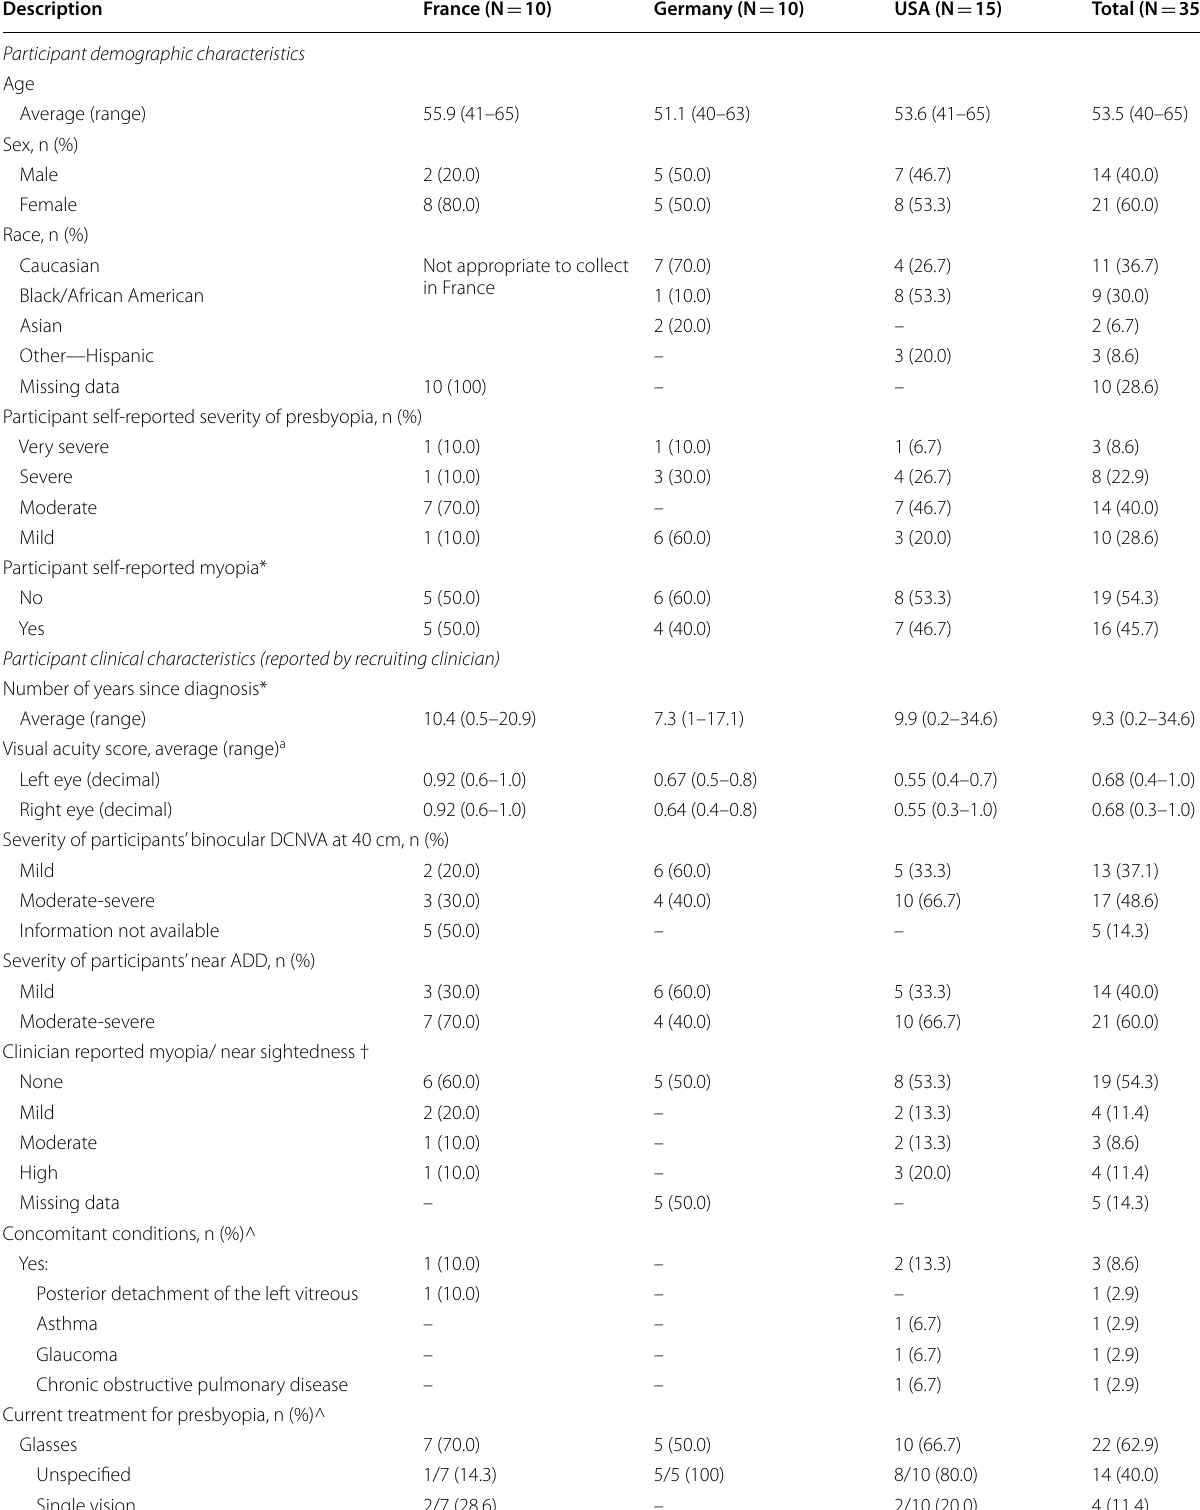
Table 2 Demographic and clinical characteristics of individuals with phakic presbyopia